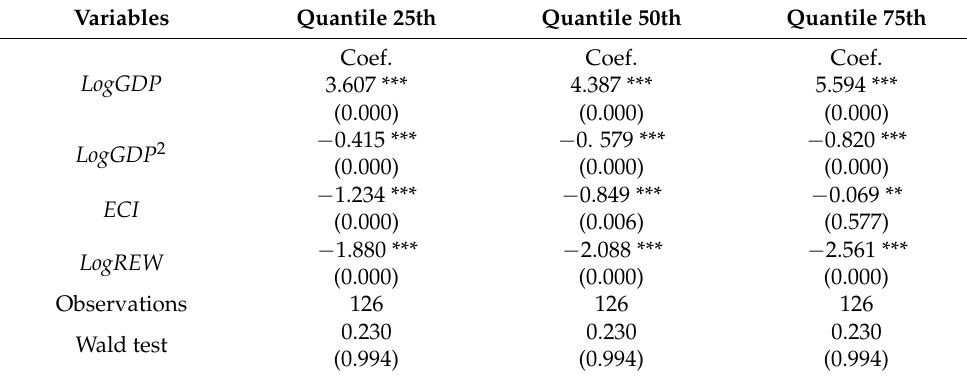
Table 7. Panel Quantiles